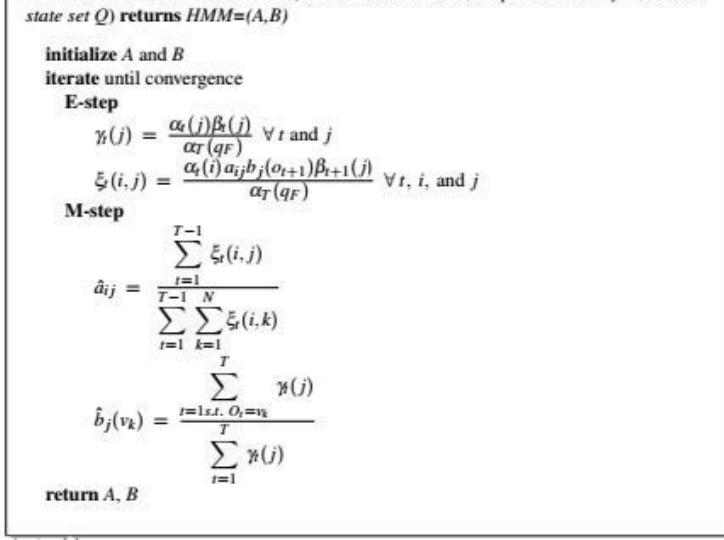
Figure 3. Example of RNTN ’ s Output After Training for Trust.